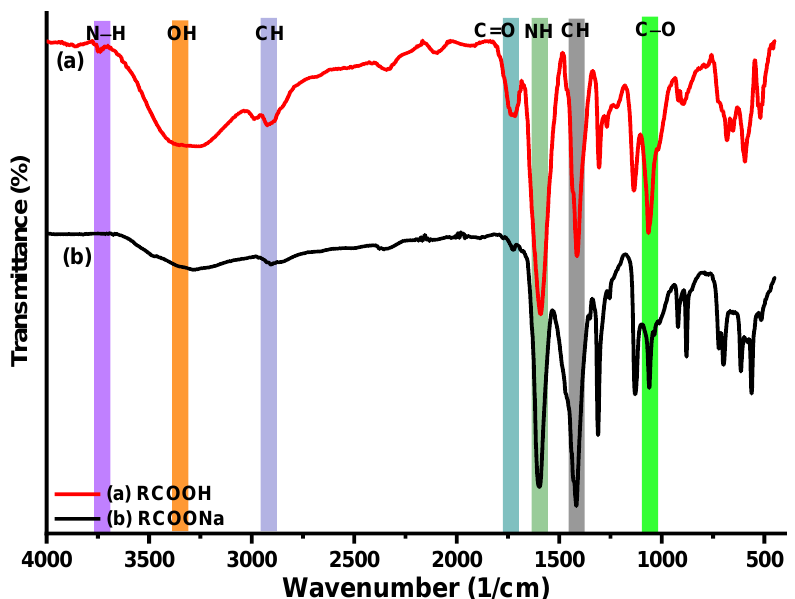
Figure 3. IR spectra of (a) RCOOH, (b) RCOONa.